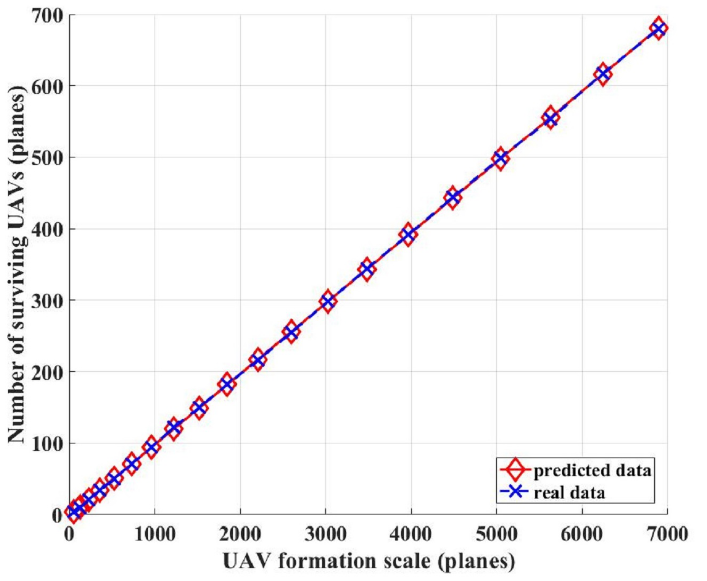
Figure 28. The regression model of the number of surviving UAVs under 85% fight loss in different- scale